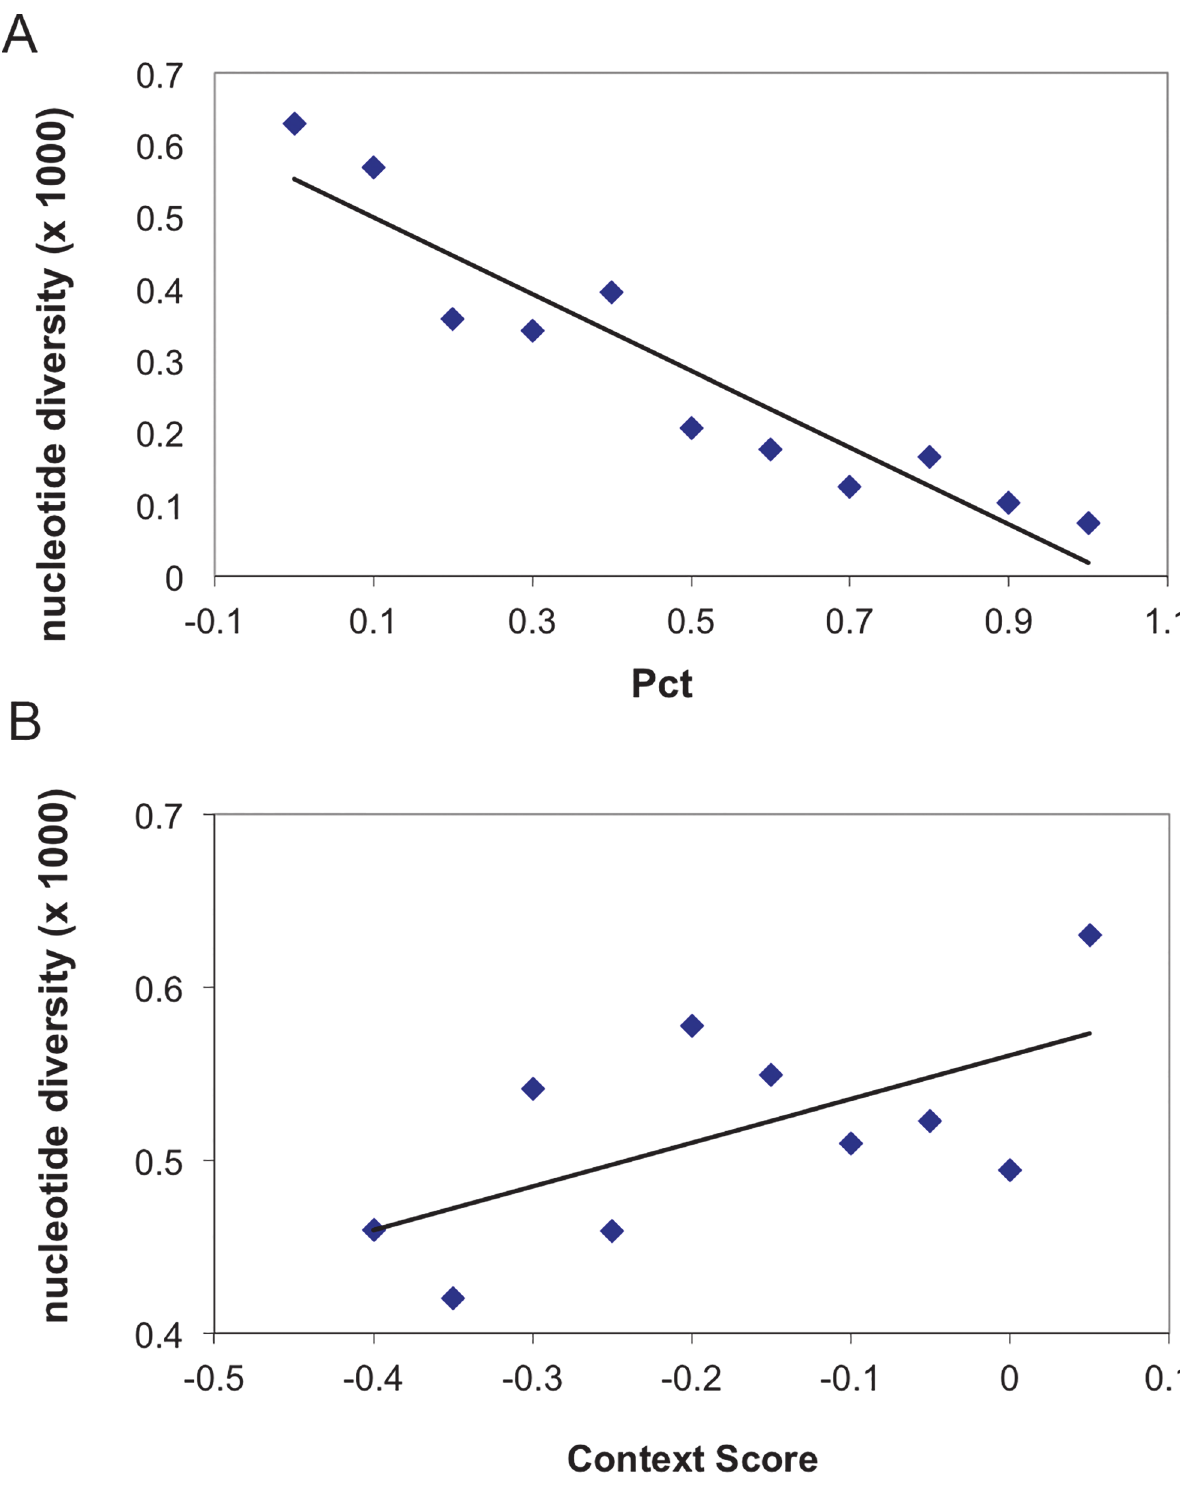
Fig 6. Nucleotide diversities ( π ) in the 3 ’ UTRs and miRNA target sites that are identified in the TargetScan program. A the target sites of the conserved miRNAs that are identified with conservation criteria of miRNA-target pairing. Sites are classified with increasing P CT score, which means higher stringency criteria. P CT = 0 means the nucleotide sites in the 3 ’ UTRs are not inside any “ seed pairing ” regions. B the target sites of the conserved miRNAs that are identified with the context score of the miRNA pairing. Smaller context scores mean the target sites have high probability to be regulated by miRNAs. The nucleotide sites in the 3 ’ UTRs that are not inside any “ seed pairing ” regions have a context score of